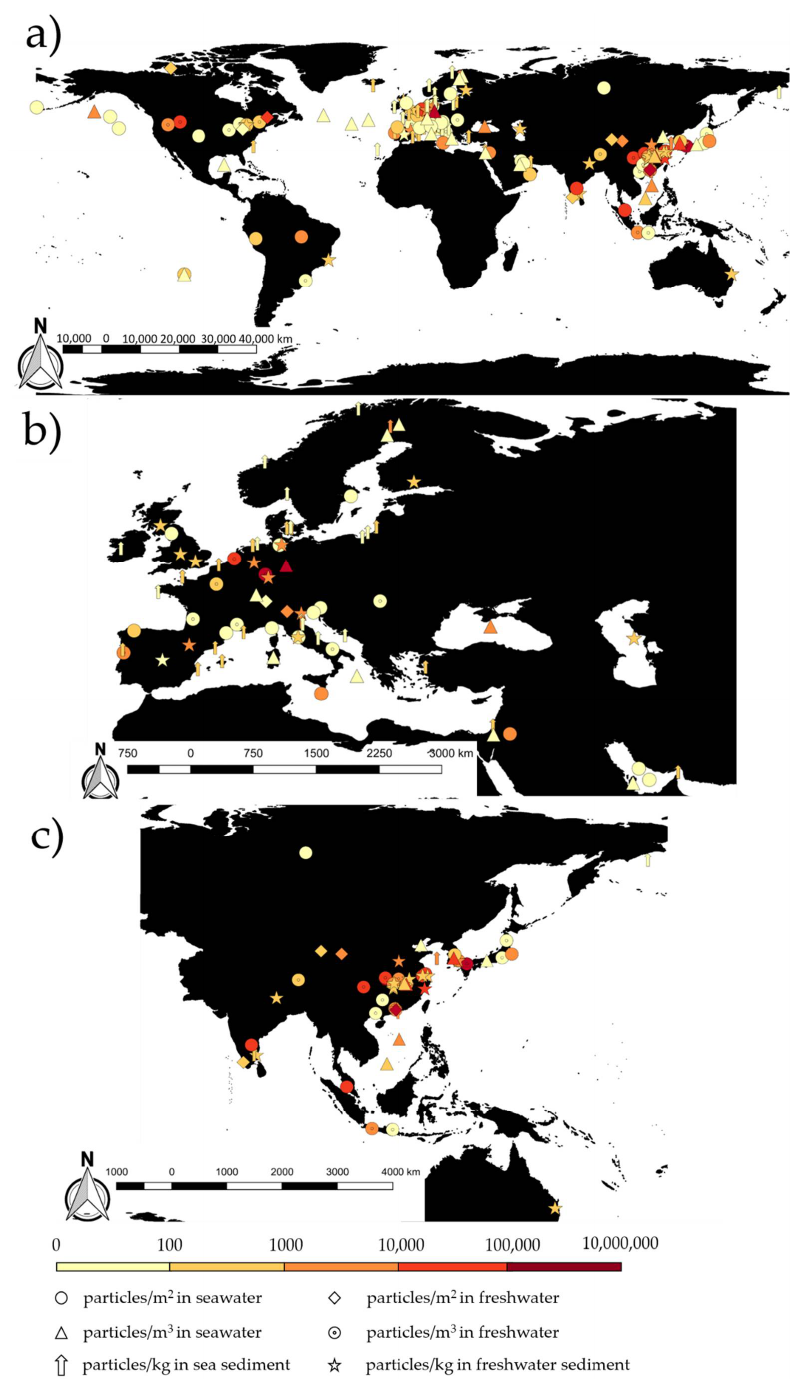
Figure 1. ( a ) Map of distribution of microplastics in aquatic environments (based on data in Tables 1 and 2); ( b ) magnification of Europe; ( c ) magnification of south-east Asia.